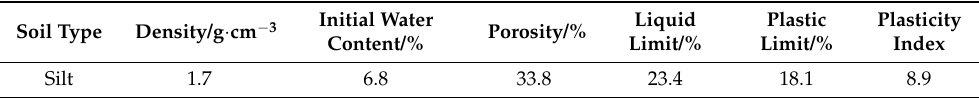
Table 2. Basic physical properties of soil